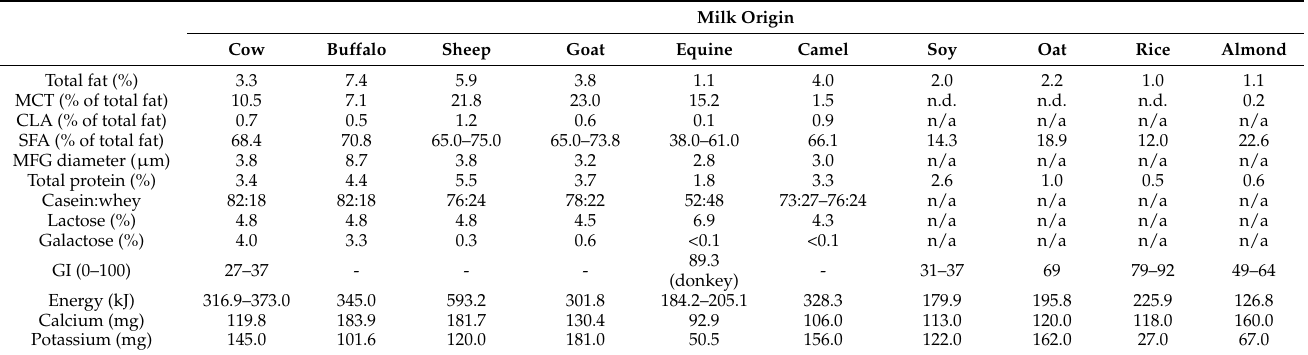
Table 2. Nutritional composition per 100 mL milk of different animal-derived milk and plant-based milk